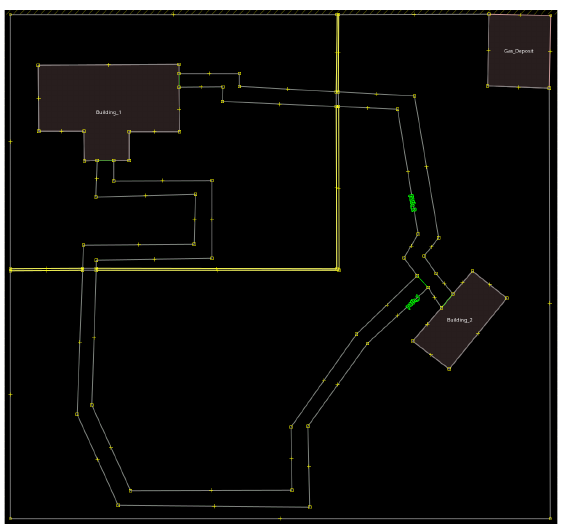
Figure 7. View of the use case from the perspective of OpenStreetMap with JOSM.